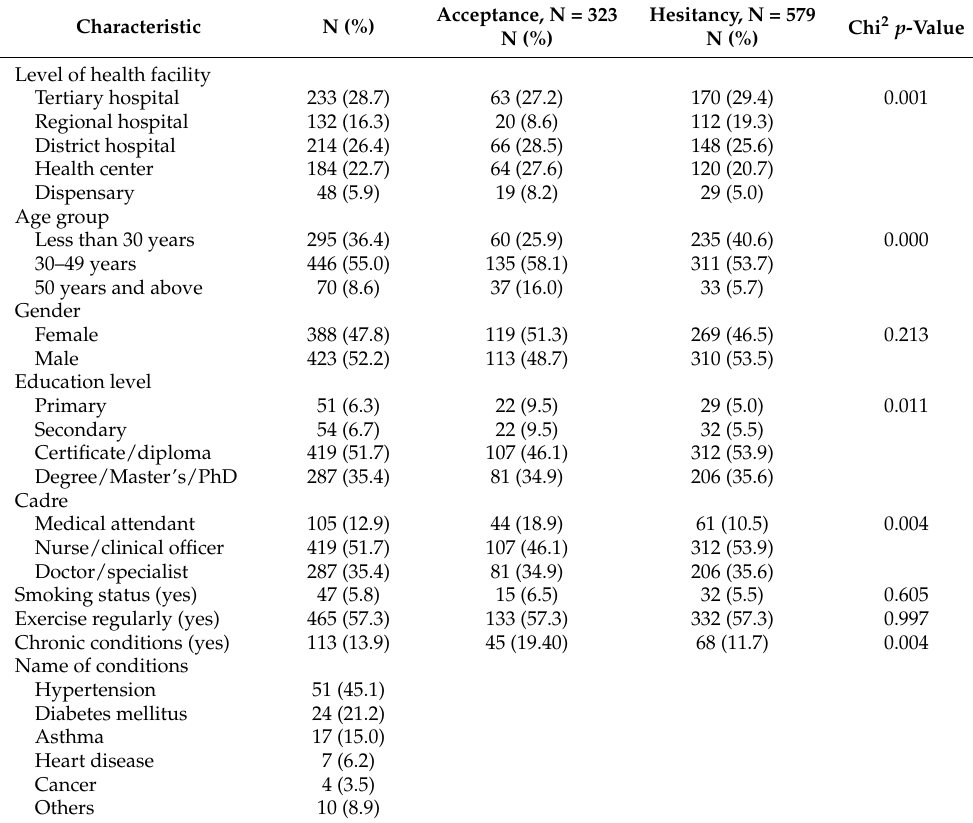
Table 1. General characteristics and reported health behaviors of health